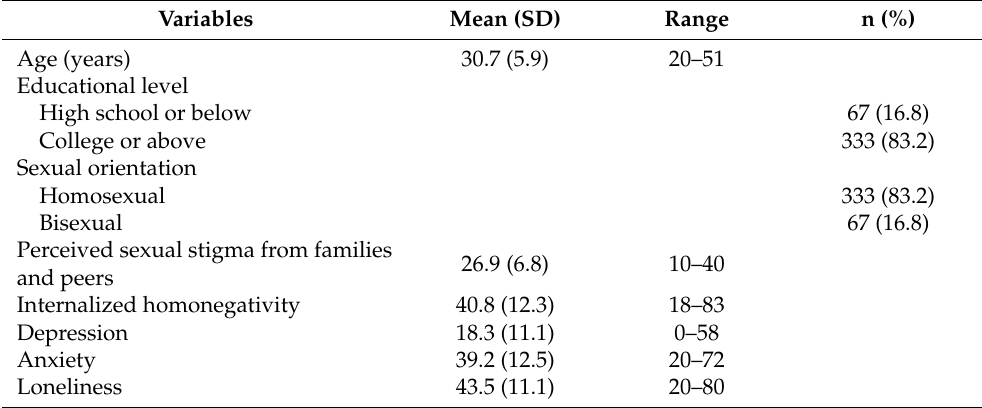
Table 1. Participant characteristics (N = 400).